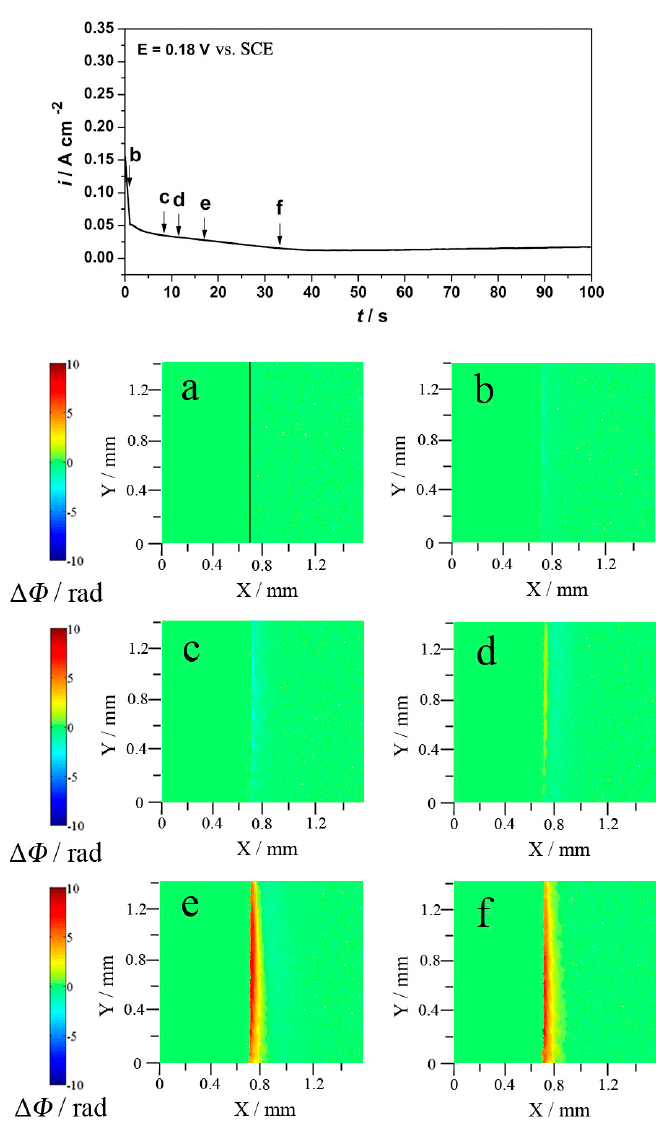
Figure 7. The i - t curve of Cu / NaCl system at 180 mV vs. SCE (Top). ( a ) was obtained at OCP. ( b – f ) are the phase maps corresponding to the points b–f in the curve.